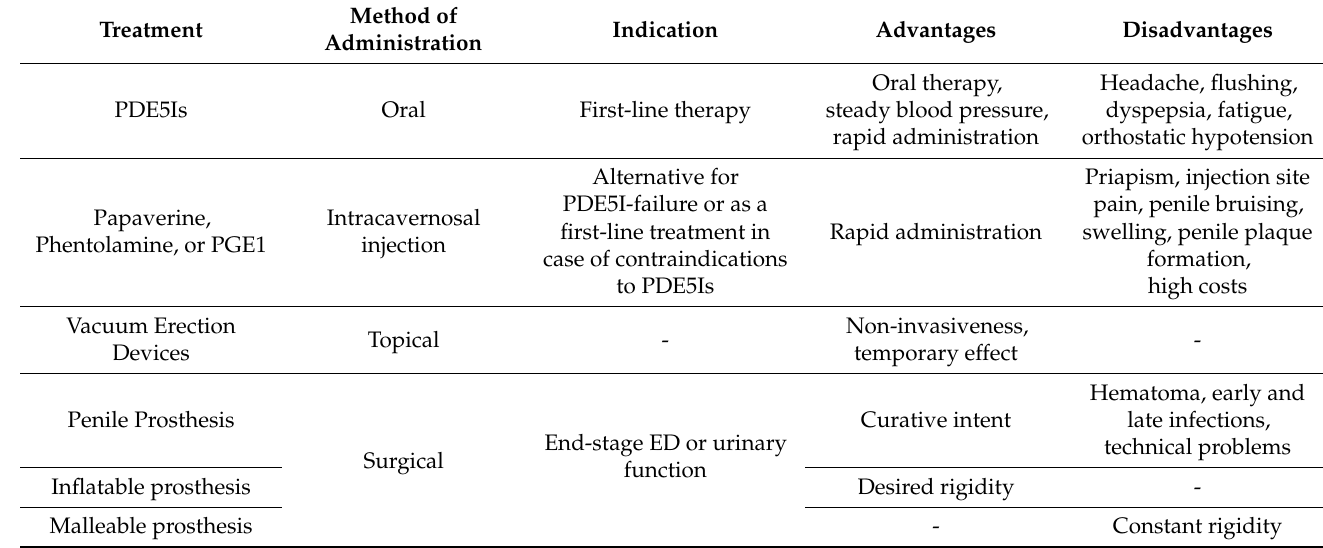
Table 2. Main treatments related to the management of ED in SCI